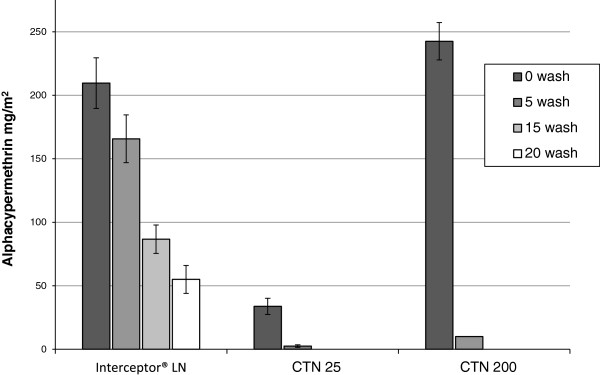
Chemical analysis of Phase I nets.